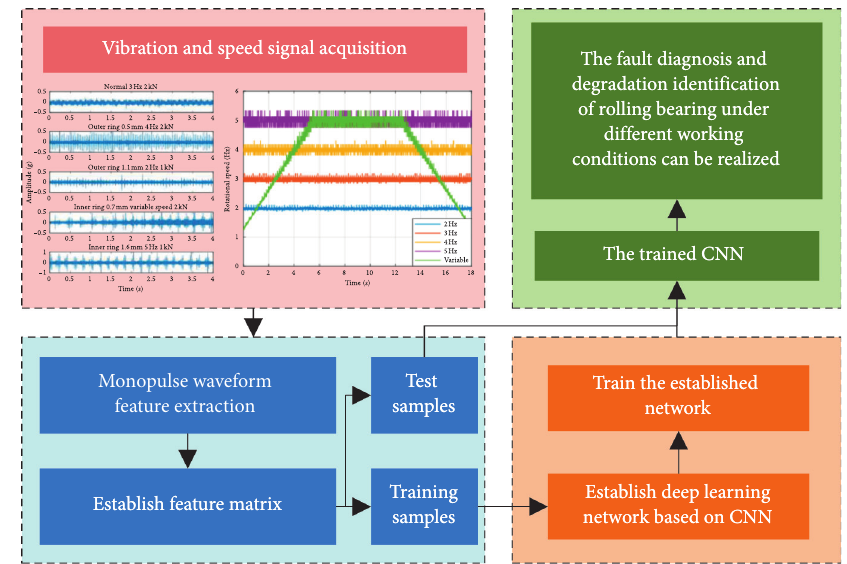
Figure 5: Bearing fault diagnosis method flow based on monopulse feature extraction and